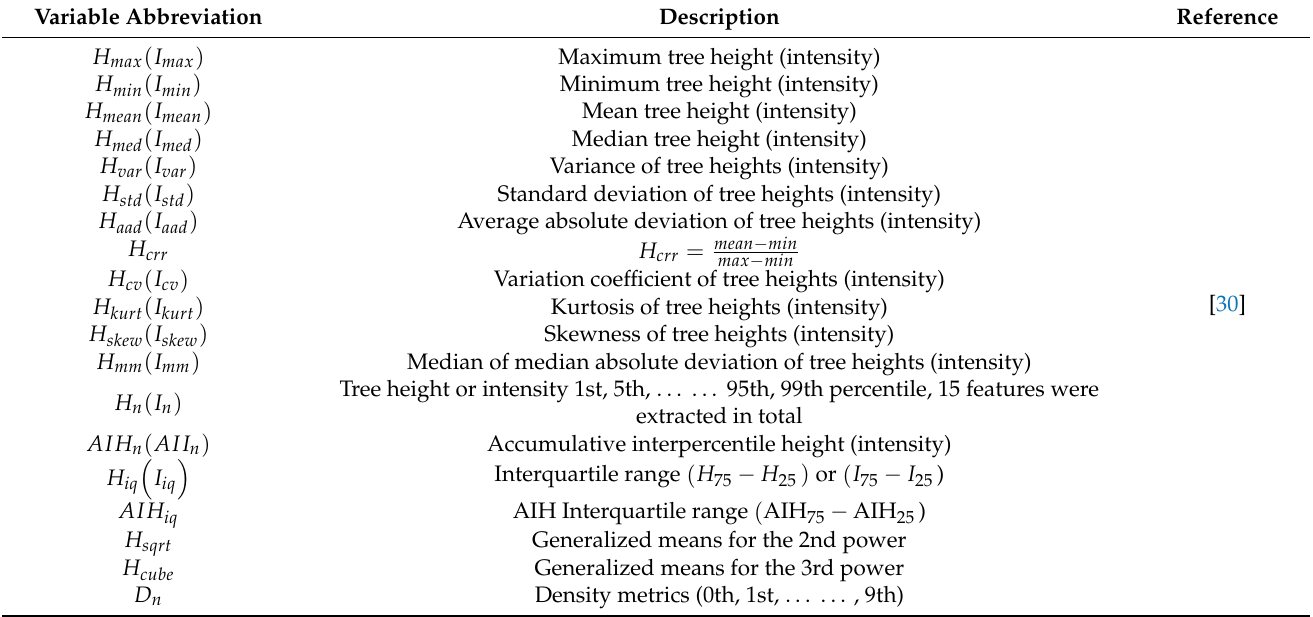
Table 4. ALS-derived tree height metrics, density metrics, and intensity